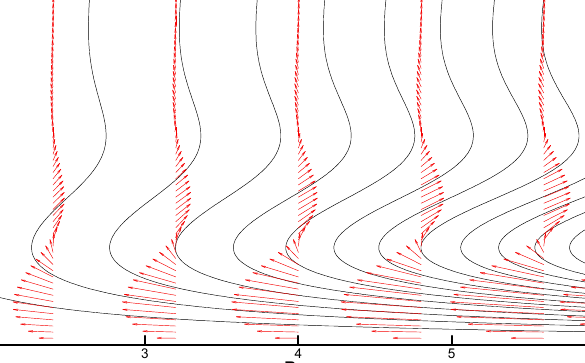
Figure 13. The meridional velocity (red vectors) and contour lines of Stokes stream function (black lines) in the Bödewadt boundary layer.